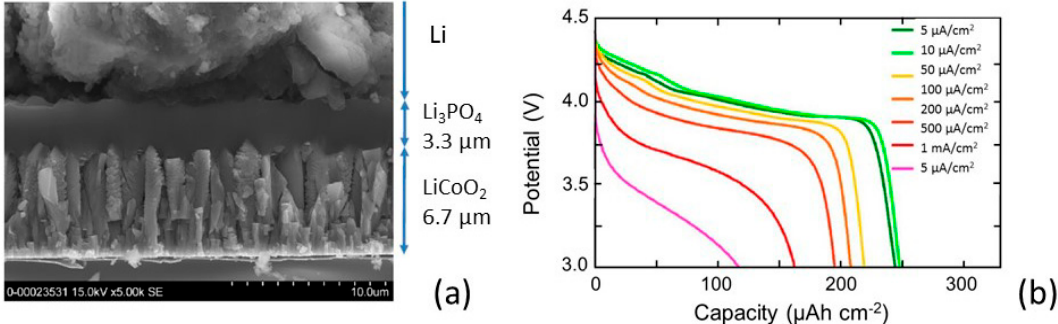
Figure 5. ( a ) SEM image cross-section of a Li/amorphous Li 3 PO 4 /LCO thin-film microbatteries. ( b ) Discharge curves for various current densities in the voltage range of 3.0 to 4.5 V vs. Li + /Li. (Reproduced with permission from [88]. Copyright 2014 Elsevier).